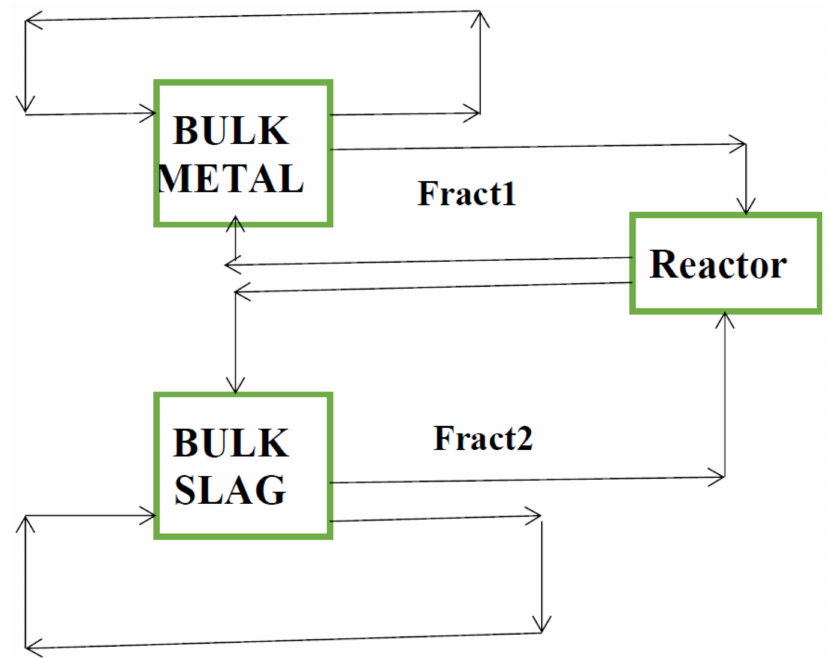
Figure A2. Interaction of different